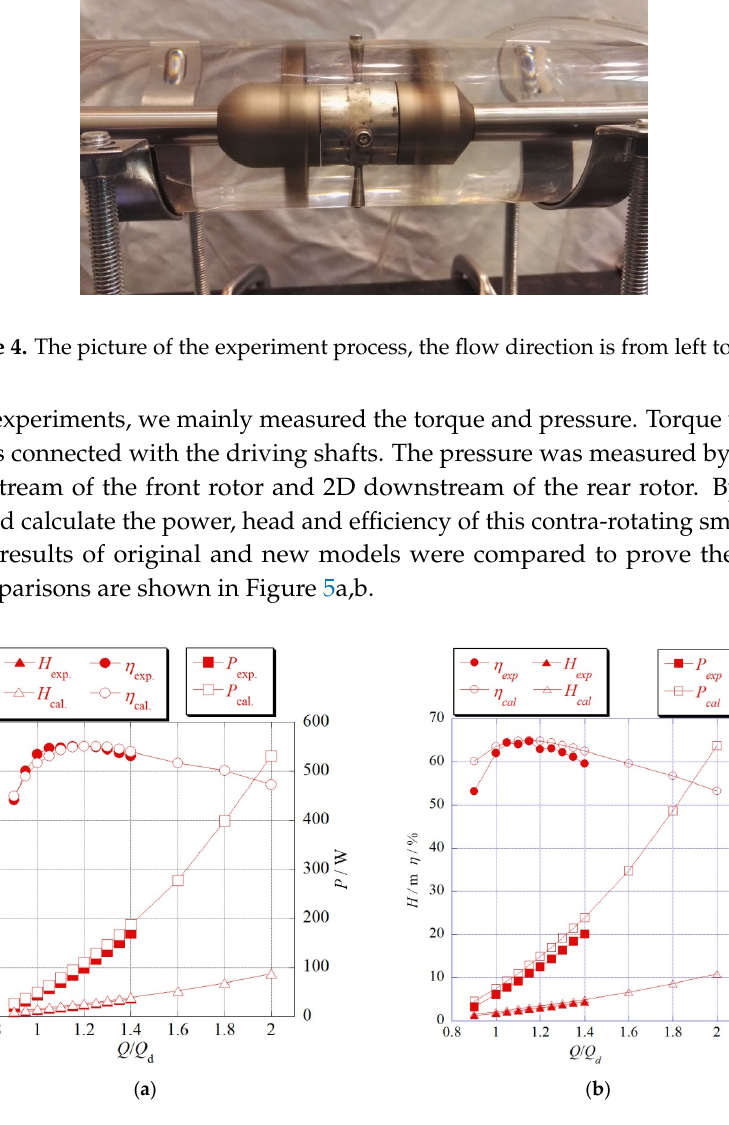
Figure 5. Comparison between experiment result and numerical result. ( a ) Comparison of the original model. ( b ) Comparison of the new model.